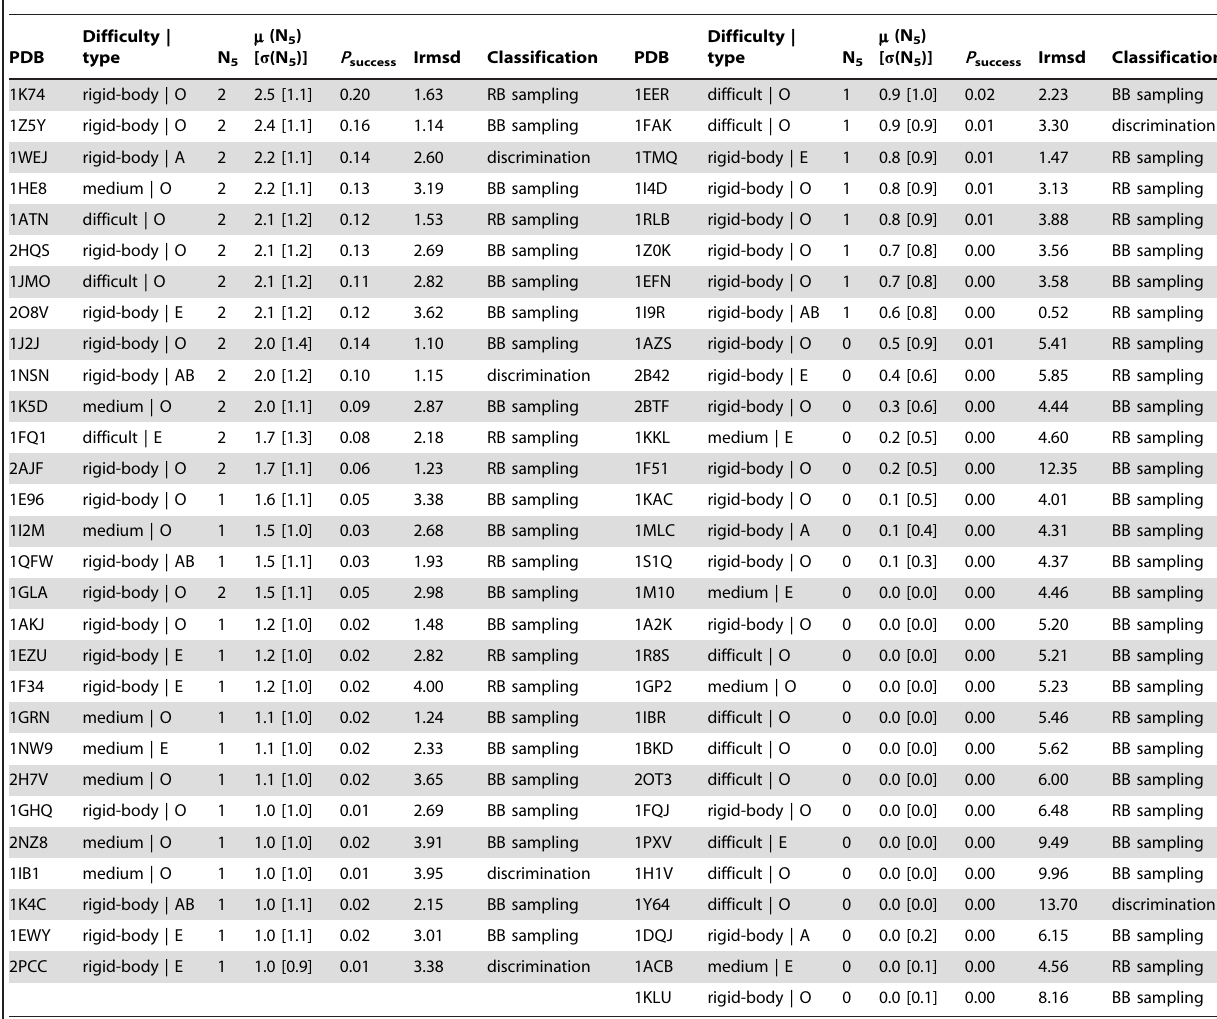
Table 3. Docking Benchmark 3.0 results summary for failures.